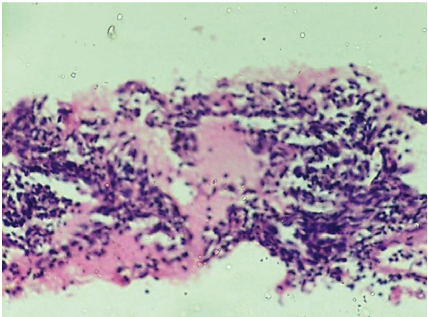
Figure 4: Low-power examination shows plugs of granulation tissue in bronchioles, alveolar ducts, and alveoli.